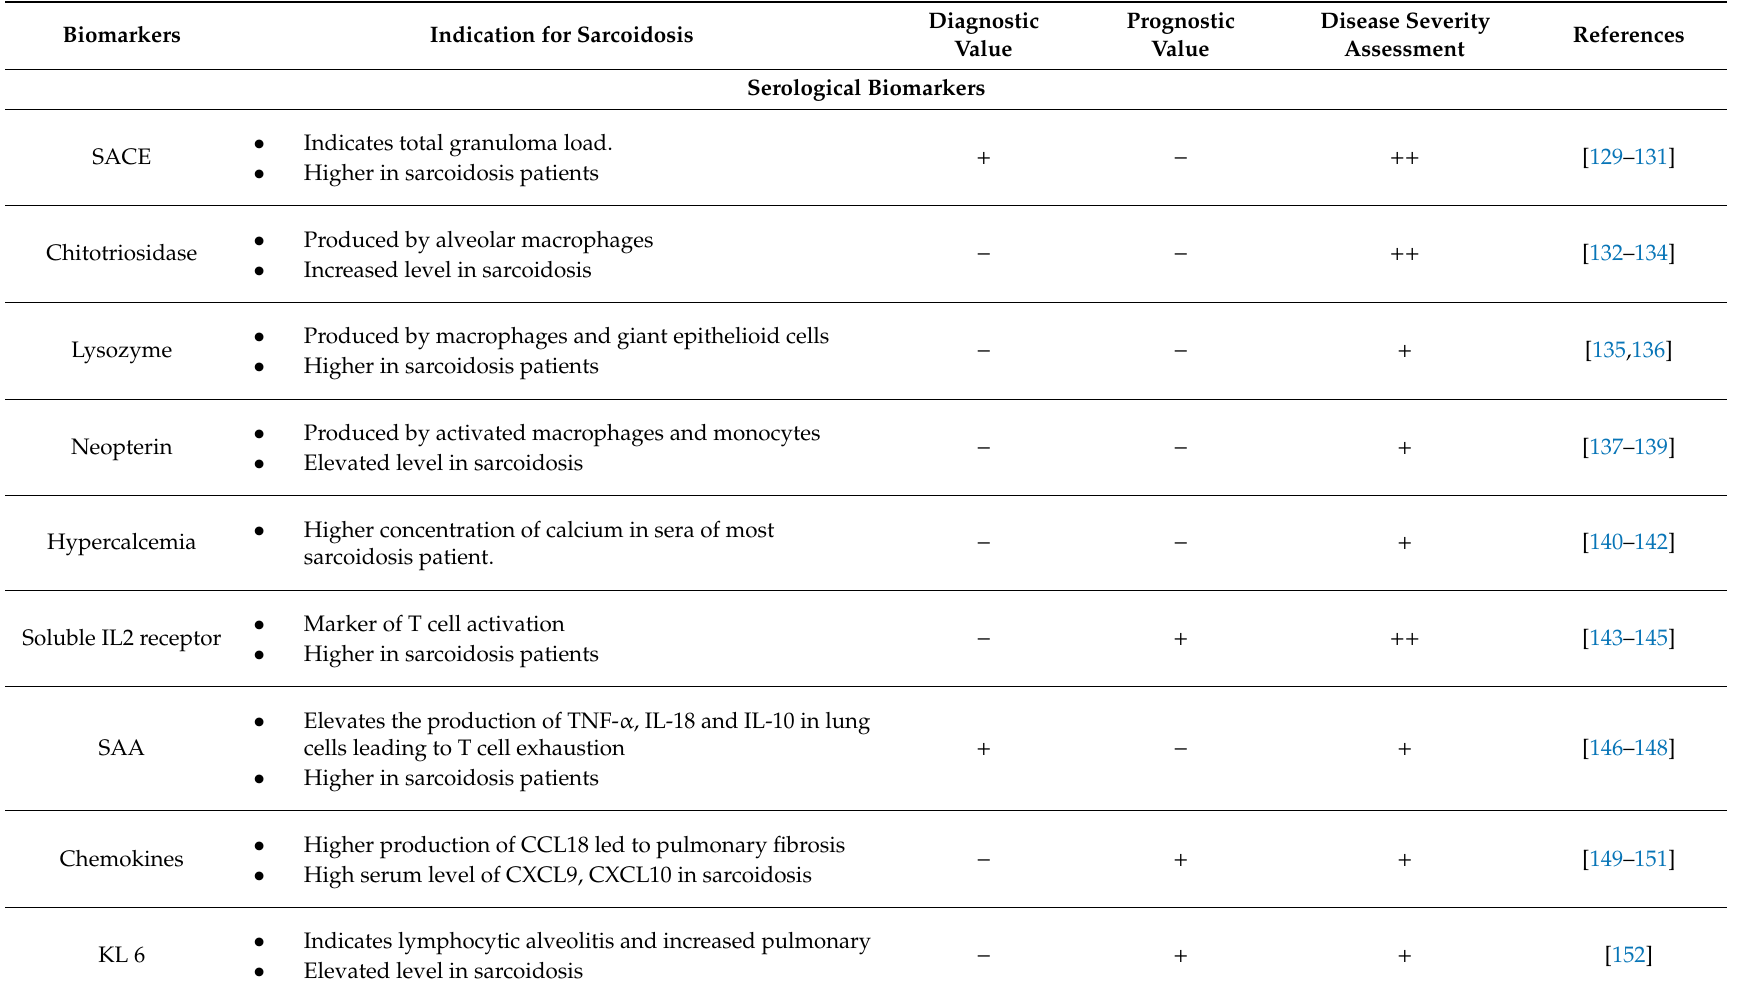
Table 3. List of potential biomarkers of